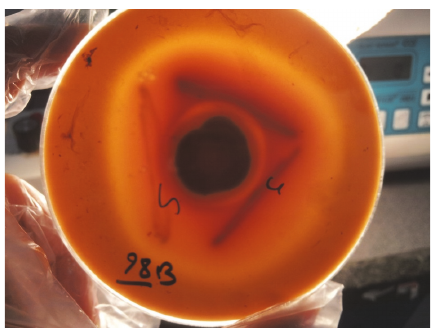
Figure 2: Cohemolytic effect: CAMP-positive (zone of half-moon shaped hemolysis) with S. aureus and S. agalactiae . CAMP-negative (left) with S. saprophyticus